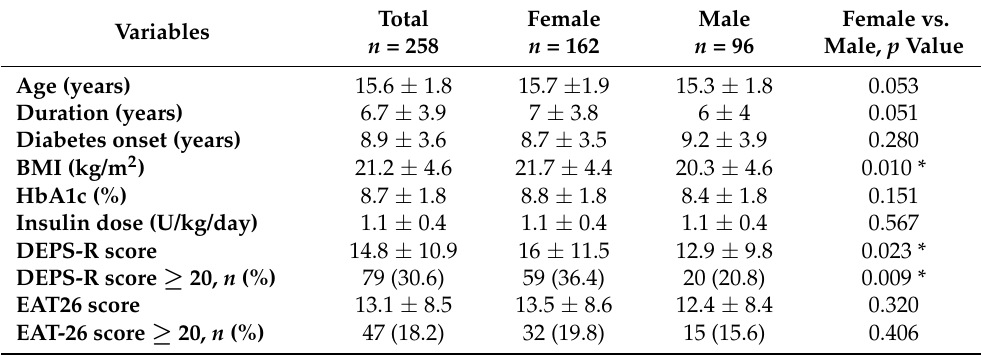
Table 1. Basic characteristics of the participants with comparison of males and females. Variables